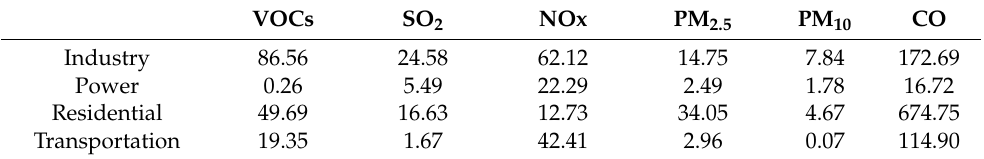
Table 2. The total emission of VOCs, NOx, PM 2.5 , PM 10 , SO 2 , and CO in HCUA during